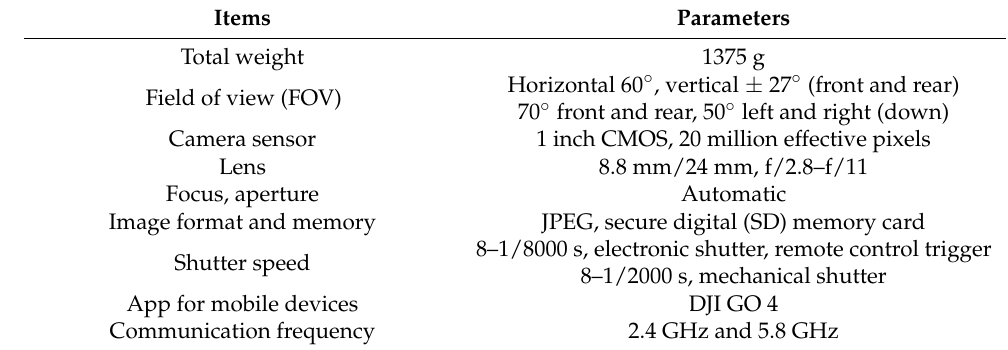
Table 2. The main technical parameters of DJI Phantom 4. Items Parameters